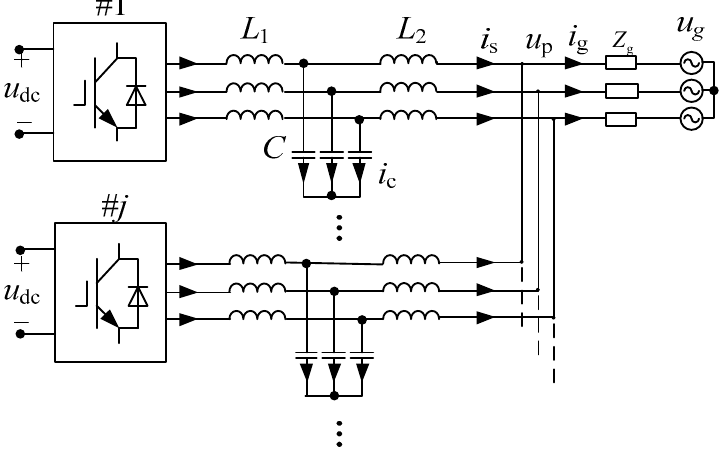
Figure 1. Equivalent circuit of the multi-paralleled inverters.